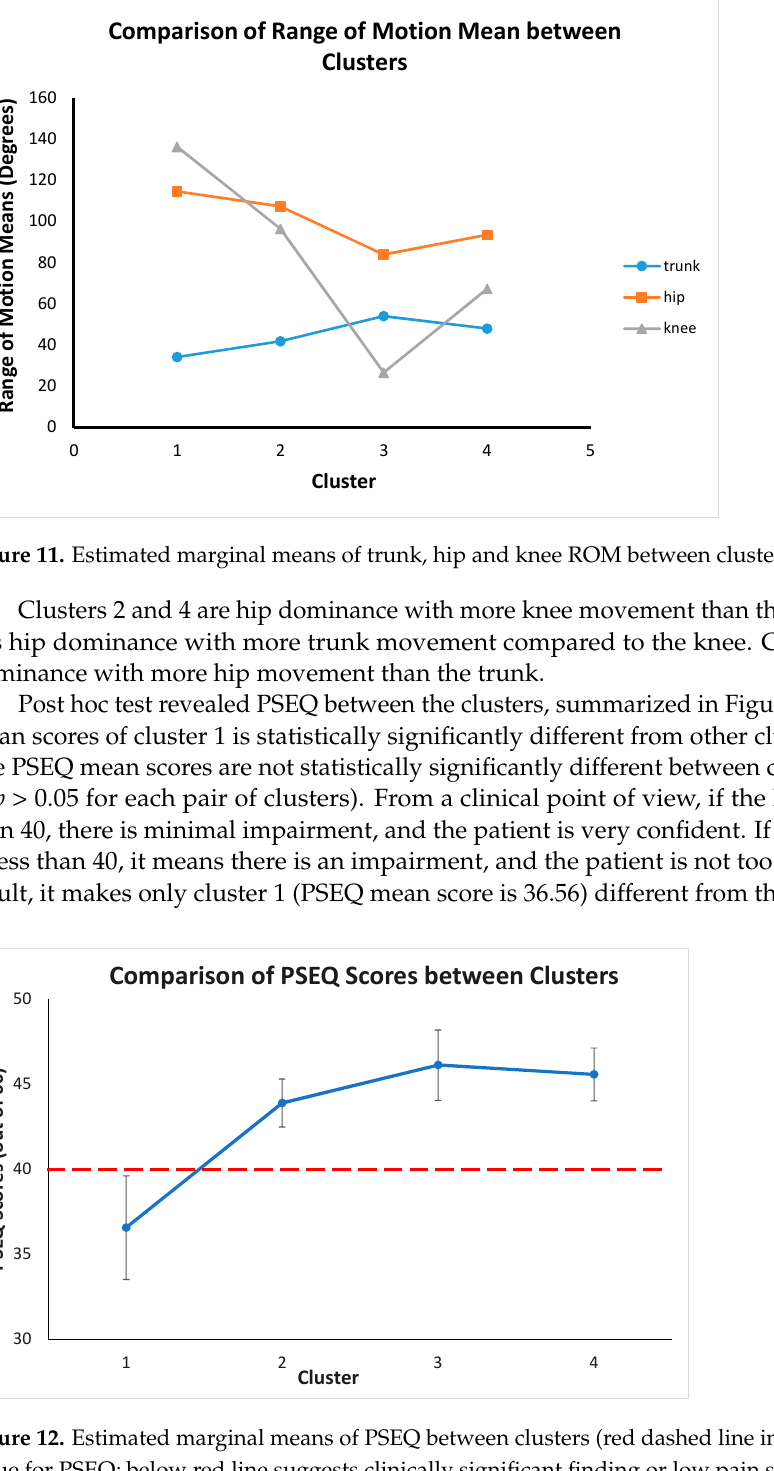
Figure 12. Estimated marginal means of PSEQ between clusters (red dashed line indicates threshold value for PSEQ; below red line suggests clinically significant finding or low pain self-efficacy).